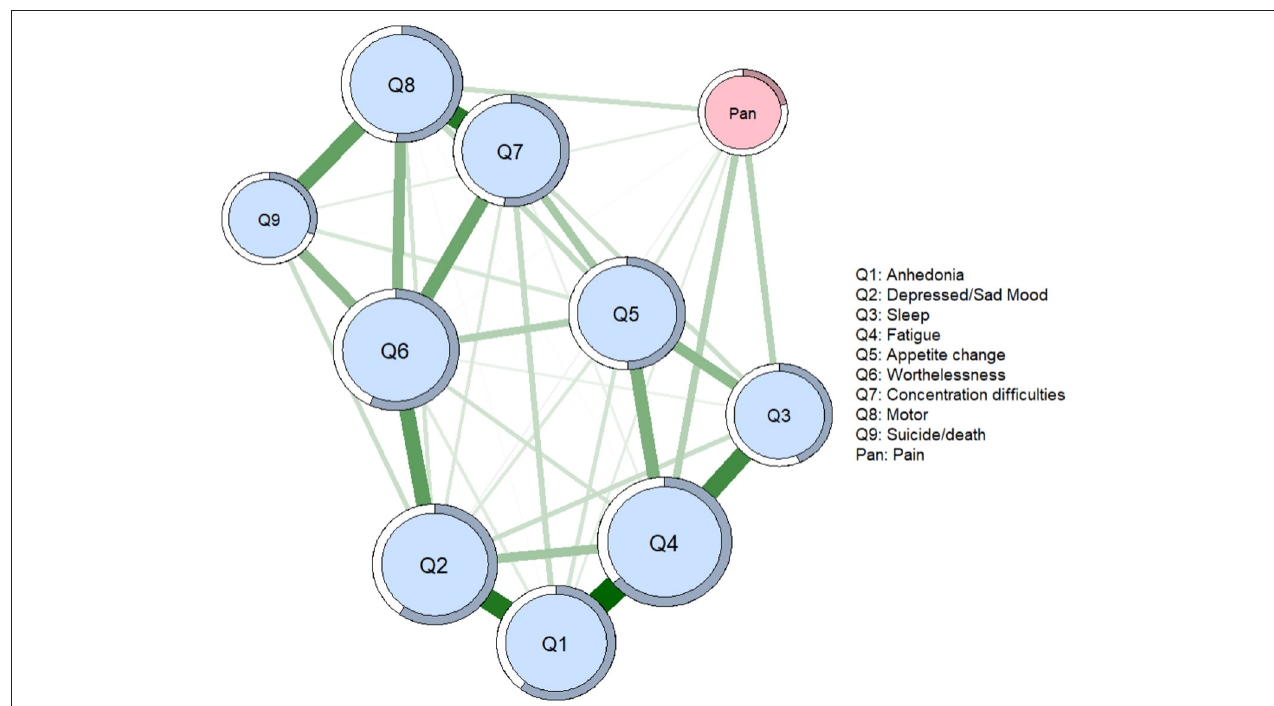
FIGURE 1 | Network of symptoms of depression and pain. In the diagram, pink node represents pain, and light blue nodes represent 9 depressive symptoms. Nodes with stronger correlations are closer to each other. The thickness of an edge indicates the strength of the correlation. Q = question from the Patient Health Questionnaire; Green lines = positive